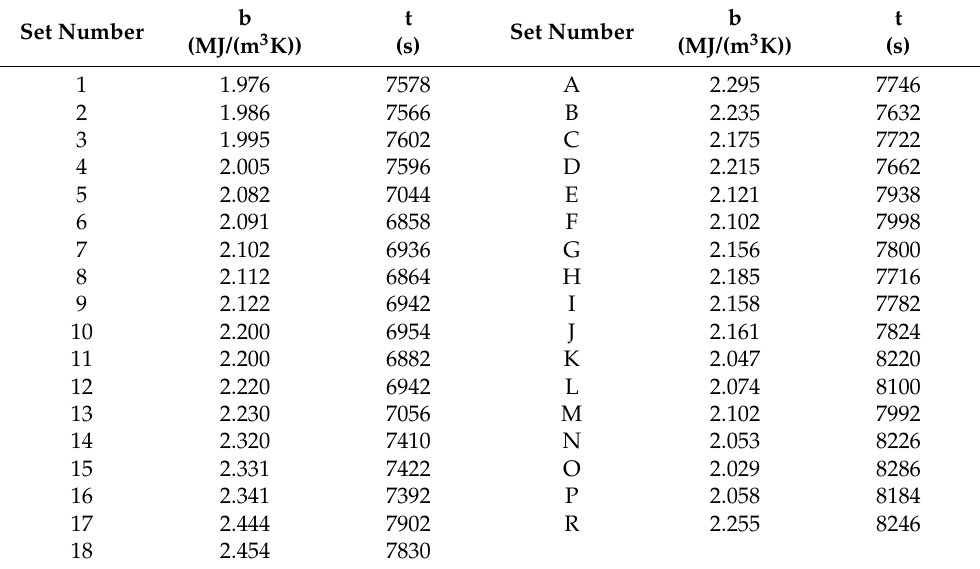
Table 6. Volumetric heat capacity b, and eutectic formation time, of three-component system: Concentrate spodumene, Albitte 5, Norfloat Spar, according to the compositions shown in Figure 1. Set Number